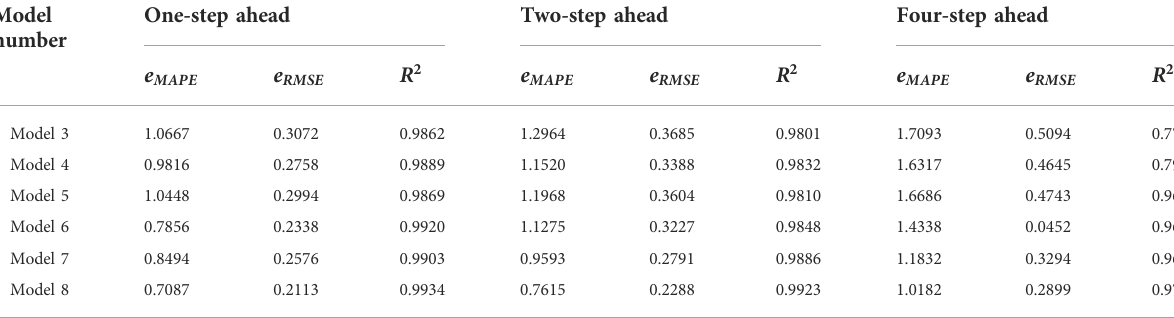
TABLE 6 Prediction results of the model combined with single decomposition technique (Case